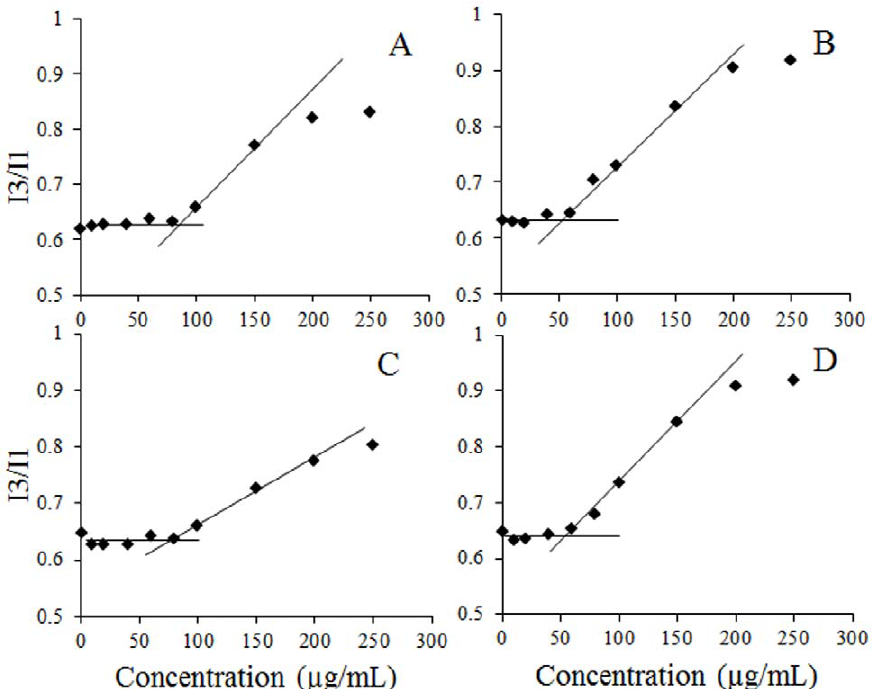
Figure 2. Critical micelle concentration of cholesterol-peptide hybrids in PBS at 25 u C. Panel A. Ch-R5H5. Panel B. Ch-R3H3. Panel C. Ch-R5. Panel D.